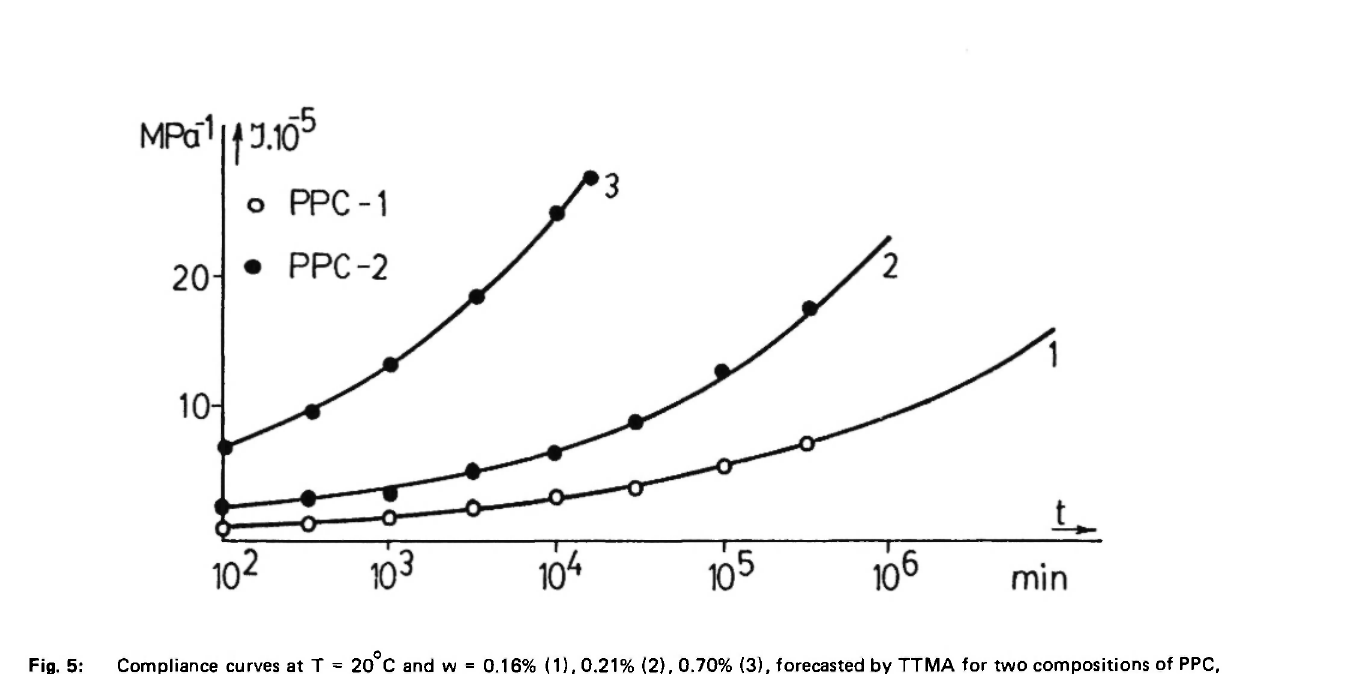
Fig. 5: Compliance curves at Τ = 20° C and w = 0.16% (1), 0.21% (2), 0.70% (3), forecasted by TTMA for two compositions of PPC, compared with experimental values obtained from control tests.